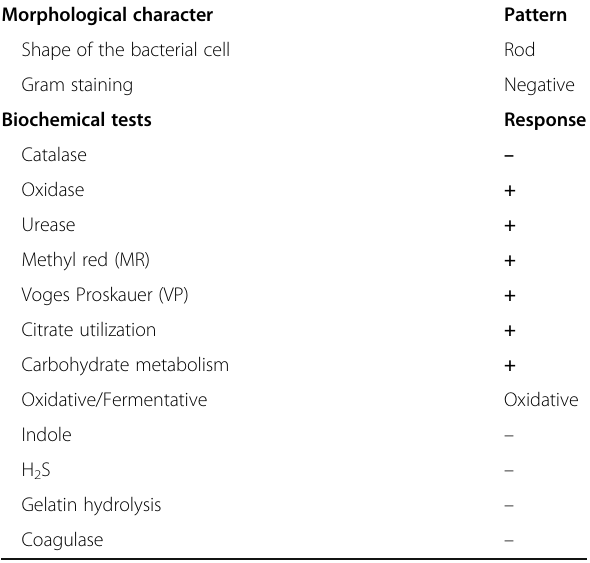
Gelatin hydrolysis